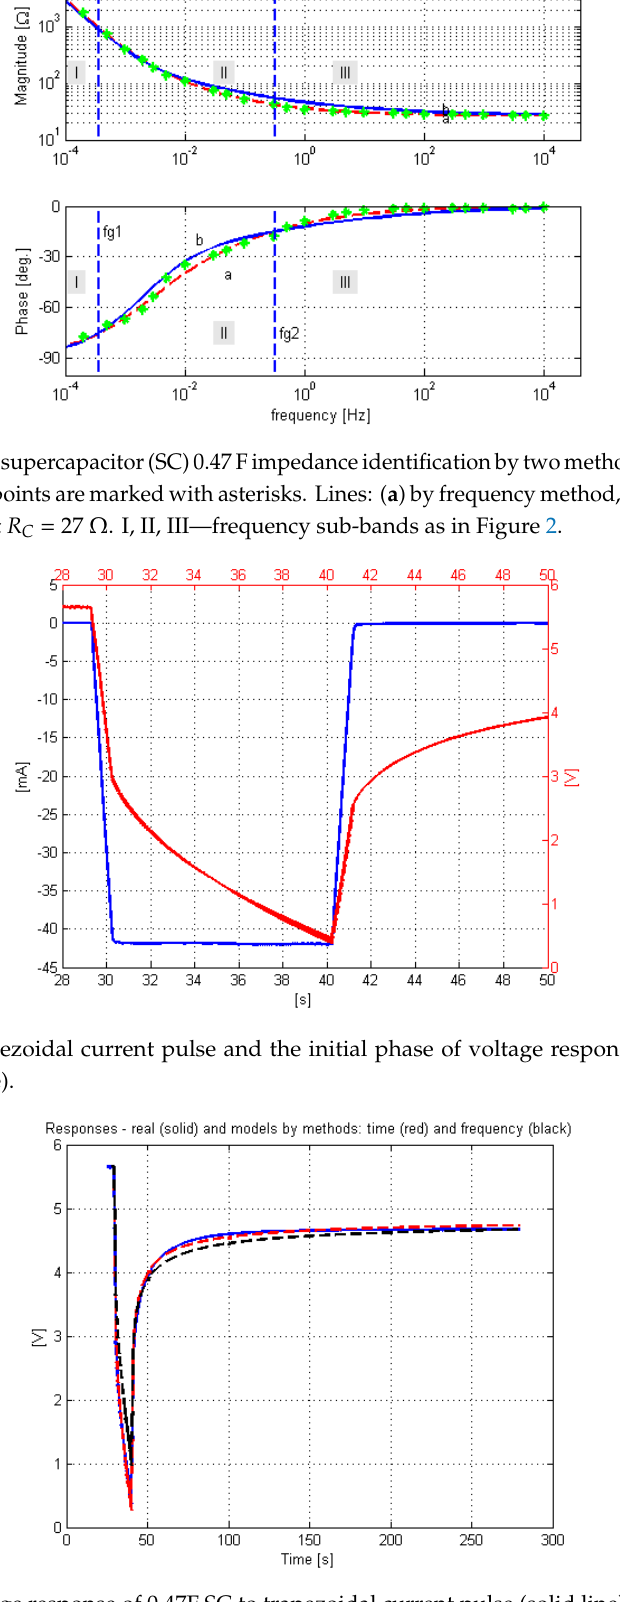
Figure 12. The voltage response of 0.47F SC to trapezoidal current pulse (solid line) and responses of models determined by frequency (black dashed line) and by time (red dashed line) methods. The method described in this article is based on minimization of the mean square error of the